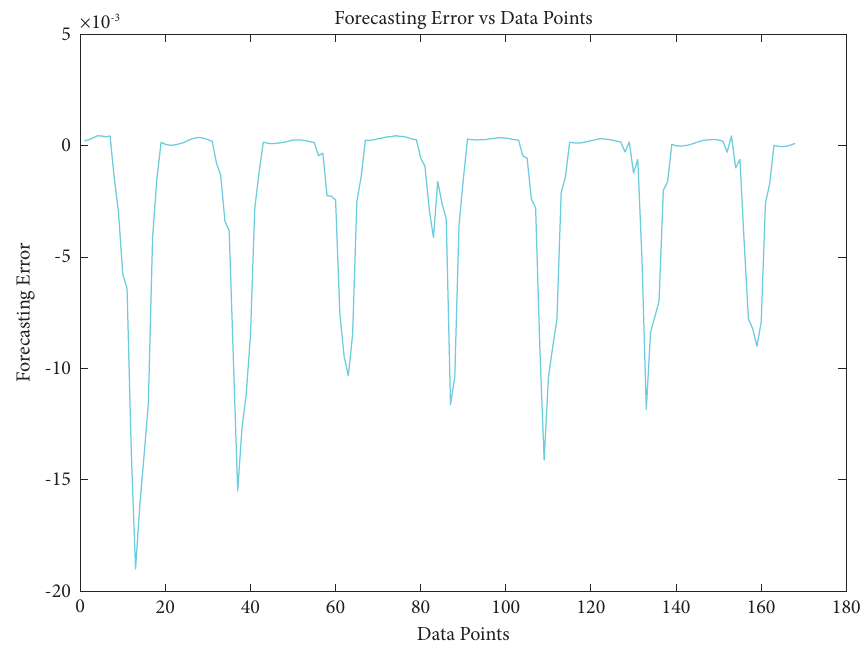
Figure 5: Forecasting error vs. data points.